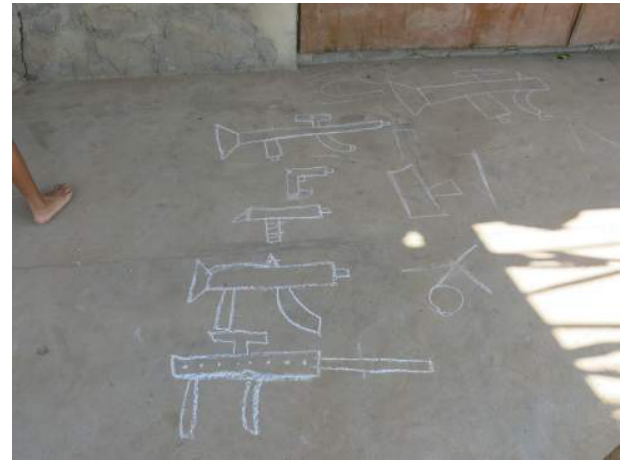
Figure 8. Children’s chalk drawings, Manguinhos,